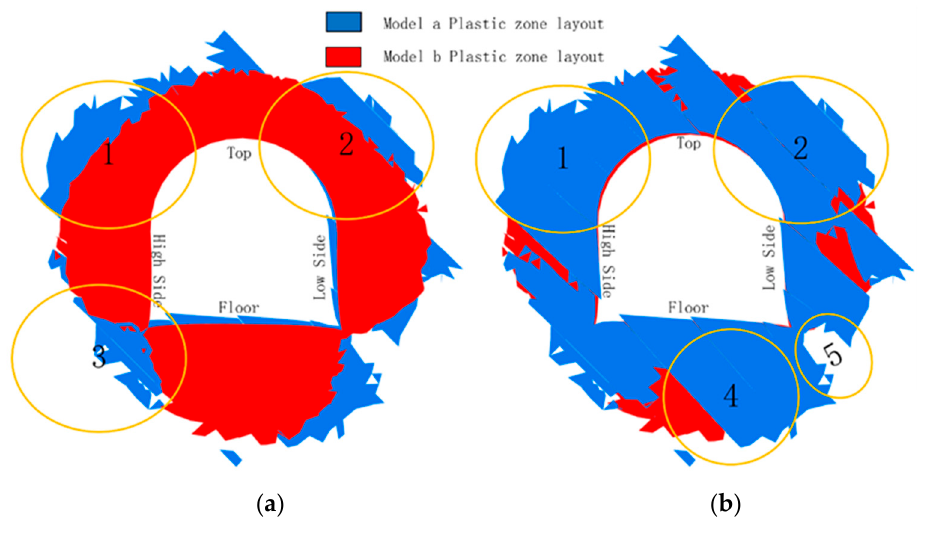
Figure 9. Comparison chart of plastic zone distribution. According to the displacement monitoring results inside the surrounding rock during similar simulations, the displacement comparison diagrams of the monitoring points at the same position from the roadway surface in the four monitoring areas were drawn, as shown in Figure 10. The figure shows that the displacement of the right upper monitoring point was the largest, followed by the displacement of the left lower monitoring point, and the displacement of the left upper monitoring point was slightly larger than that of the right lower monitoring point. Comparing Figure 9, it could be found that the right upper and left lower monitoring points were located in the tangent zone between the rock formation and the roadway boundary (zone 2 and zone 3). The depth of the plastic zone in the area where the right upper point was located was larger than that in the area where the left lower point was located. At the same time, the roadway surface in the right upper area was parallel to the rock formation, while the roadway surface in the left lower area intersected at right angles. The left upper zone was located in the tangential vertical area between the rock formation and the roadway, and the right lower zone was in zone 5 at the junction of the low side and the floor.